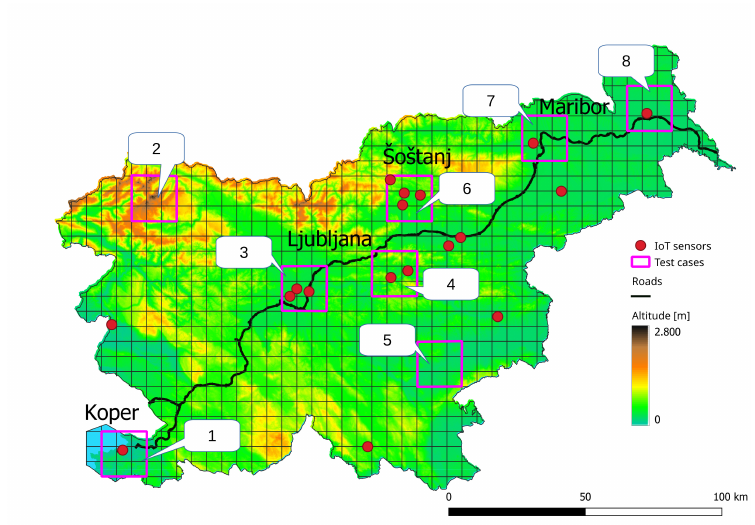
Figure 5. Location of the IoT ground sensors for NO 2 and the eight testing